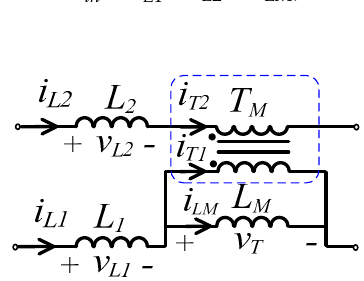
Figure 3. Equivalent circuit for the coupled inductor.